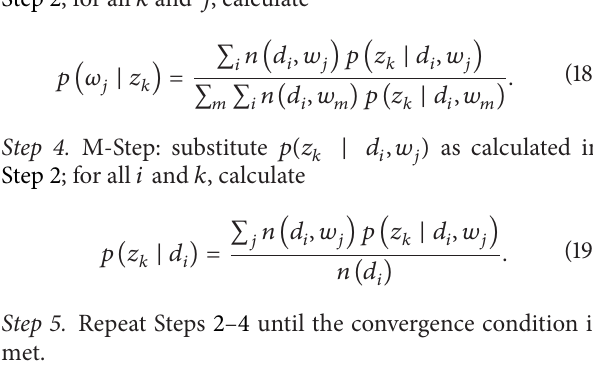
Algorithm 2. Training of the pLSA for